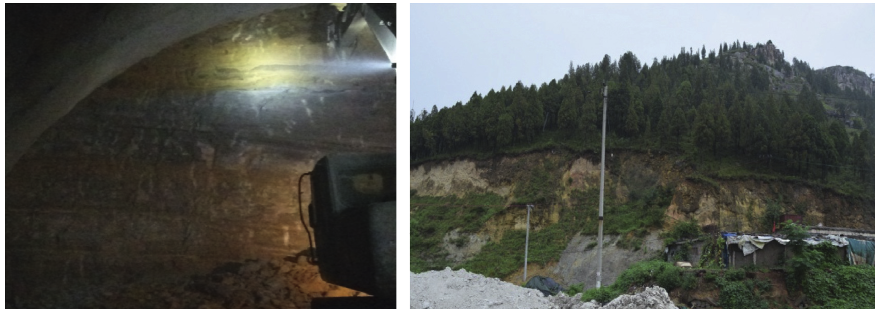
Figure 2: Rock mass condition of Grade IV strengthening section in Laohushan